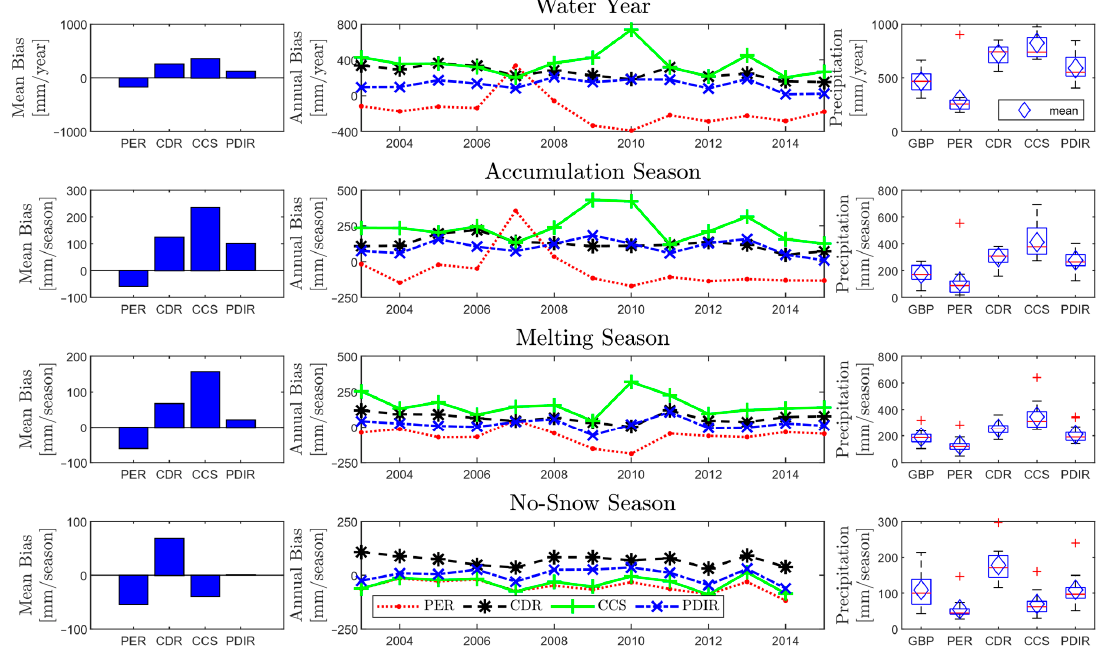
Figure 5. Annual PVE of SBP data set * GBP: Gauge-based Precipitation, PER: PERSIANN, CDR: PERSIANN-CDR, CCS: PERSIANN-CCS, PDIR: PERSIANN-PDIR-Now.